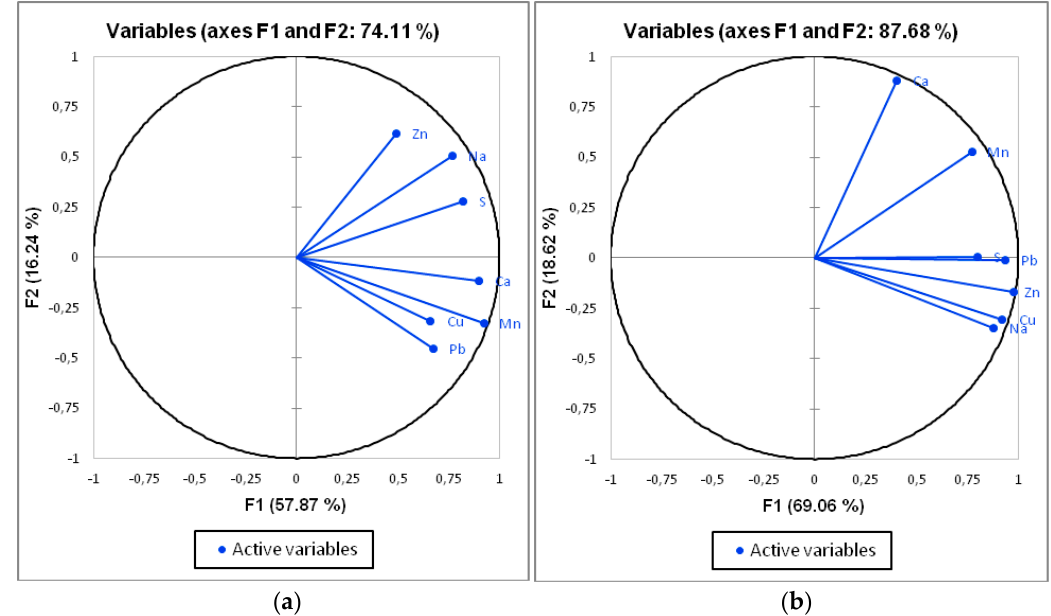
Figure 4. Graph presenting variables in a system of two initial factorial axes for soil at the end of the first ( a ) and second ( b ) year of cultivation. first ( a ) and second ( b ) year of